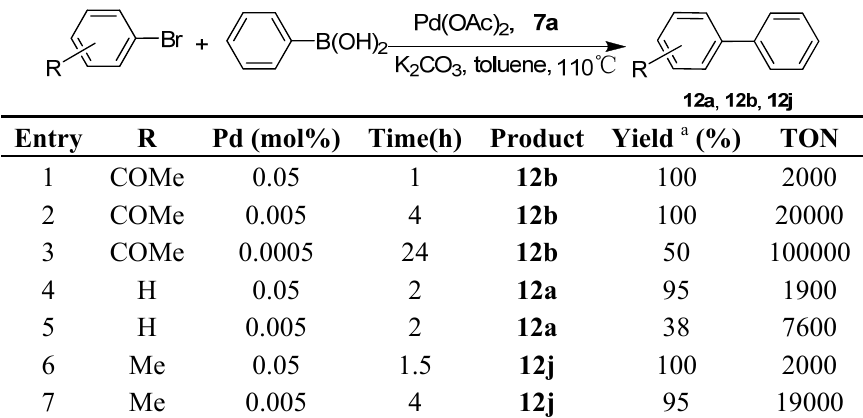
/ 7a with variation of loading. 2